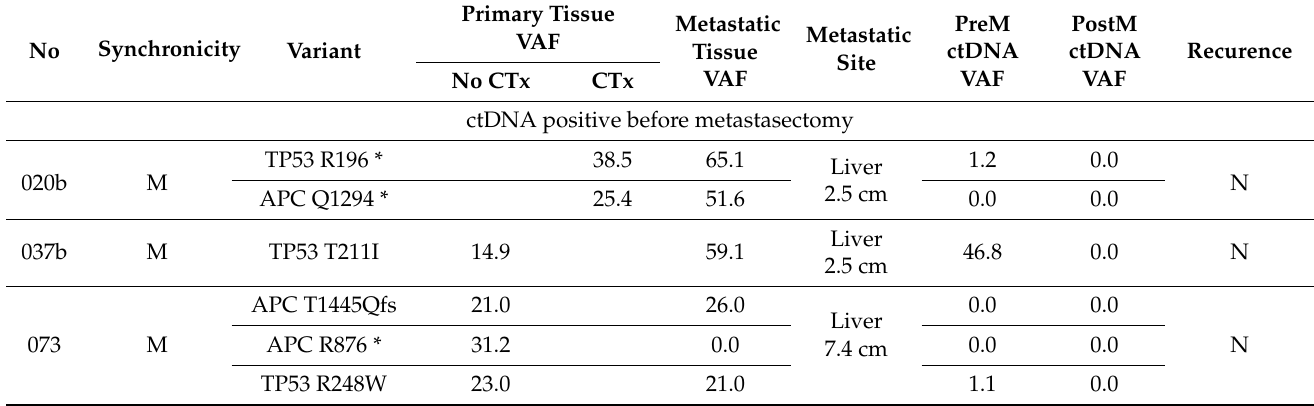
Table 2. Metastasectomy (R0 resection) Without Chemotherapy ( N event =